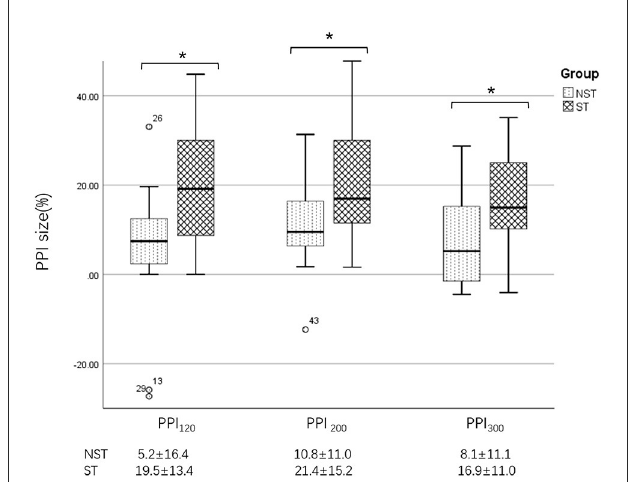
FIGURE5 Differences in PPI size between the ST and NST groups. PPI 120 , prepulse inhibition at ISIs of 120ms; PPI 200 , prepulse inhibition at ISIs of 200ms; PPI 300 , prepulse inhibition at ISIs of 300ms. All comparisons were performed using the independent-sample t -test. * p <